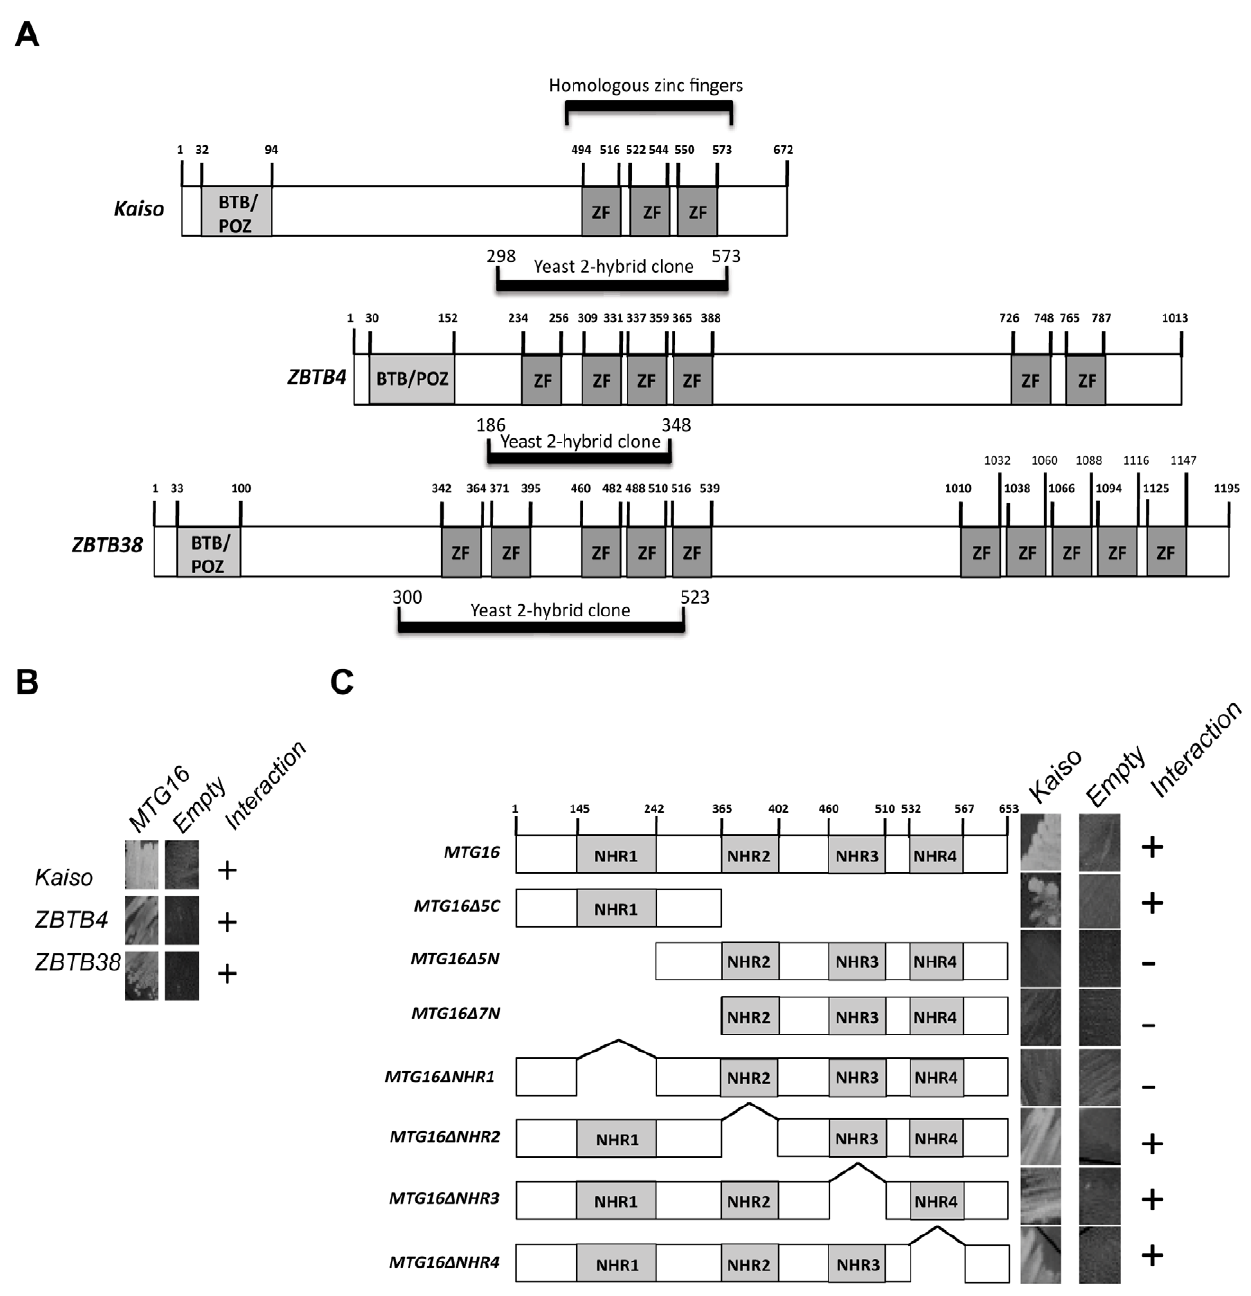
Figure 1. ZBTB family members interact with MTG16. A. ZBTB family member alignment based on homologous zinc fingers and identification of amino acids used in yeast-two hybrid experiments (yeast two-hybrid clones). B. Yeast-two hybrid assay for interactions between ZBTB family members and MTG16. C. Mapping of the Kaiso binding site on MTG16. Yeast two-hybrid assays were performed in triplicate.